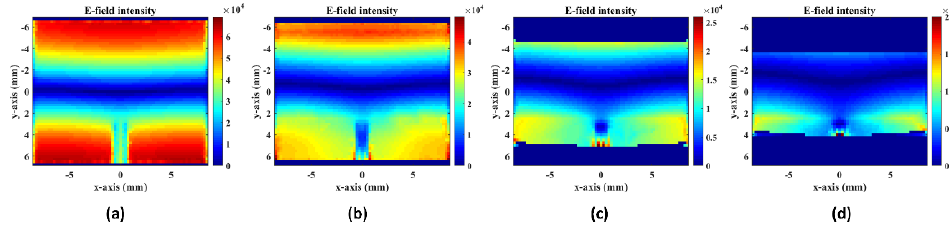
ρ -direction with different bending an-